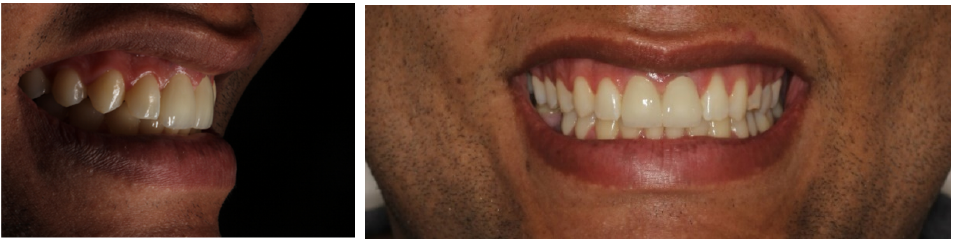
Figure 13. Prosthetic finish completed with veneered porcelain-cemented crowns.